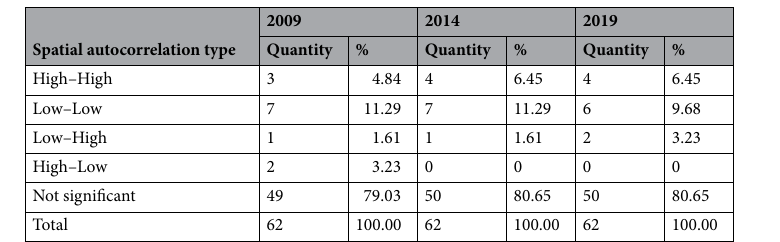
Table 5. Local spatial autocorrelation types of water ecological security target layer in 62